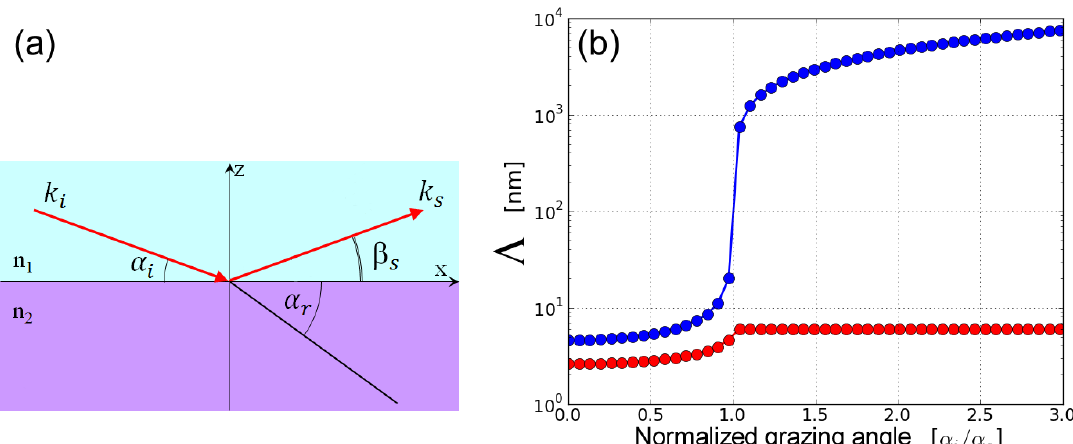
Figure 2. ( a ) Reflection and refraction of an incident X-ray beam at the plane of incidence. ( b ) The penetration depth in water depending on the incident grazing angle (blue curve). Red curve shows the effective penetration depth depending on the outgoing grazing angle with the incident angle fixed at 65% of the critical